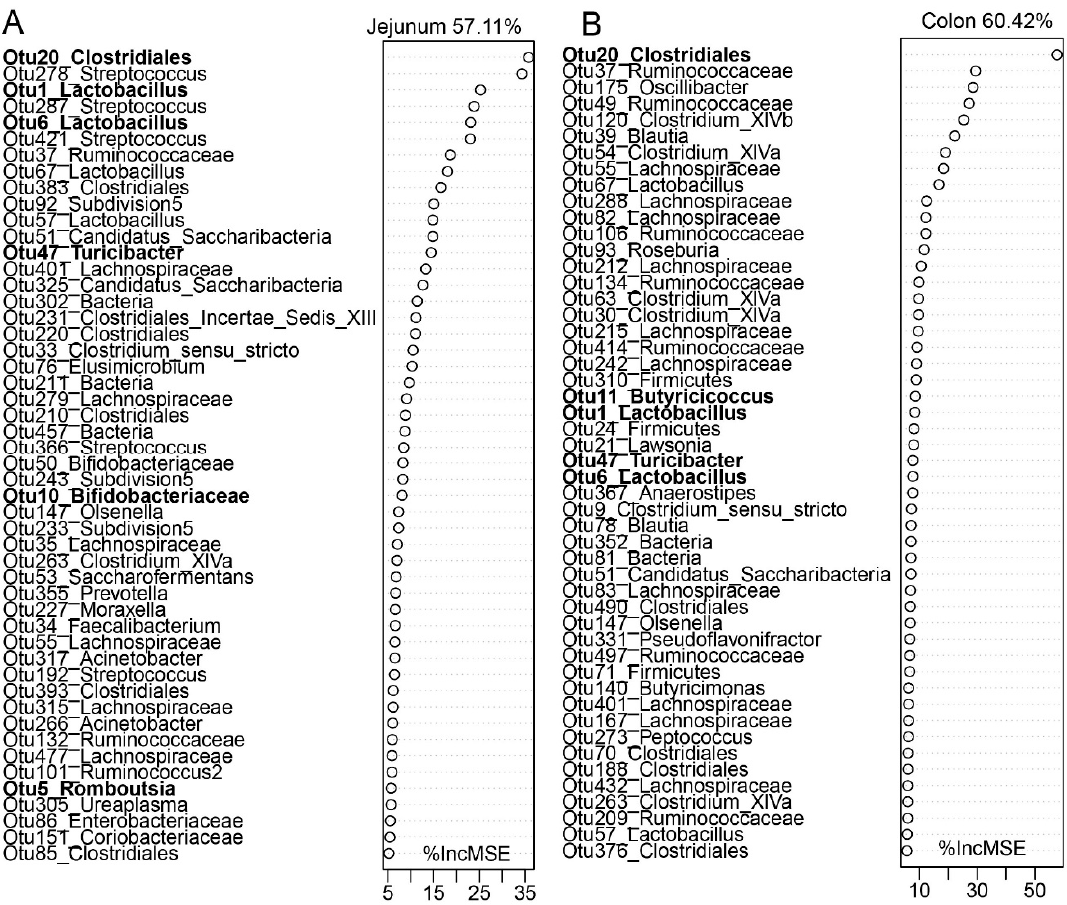
Figure 8. Growth performance-related bacteria identified by a random forest regression model. The top 50 growth-related (body weight) signature microbiota of the jejunum ( A ) and colon ( B ) in goat kids were listed based on the mean square error of predictions (%IncMSE). The bolded features denote potential probiotics or important commensal microbiota.